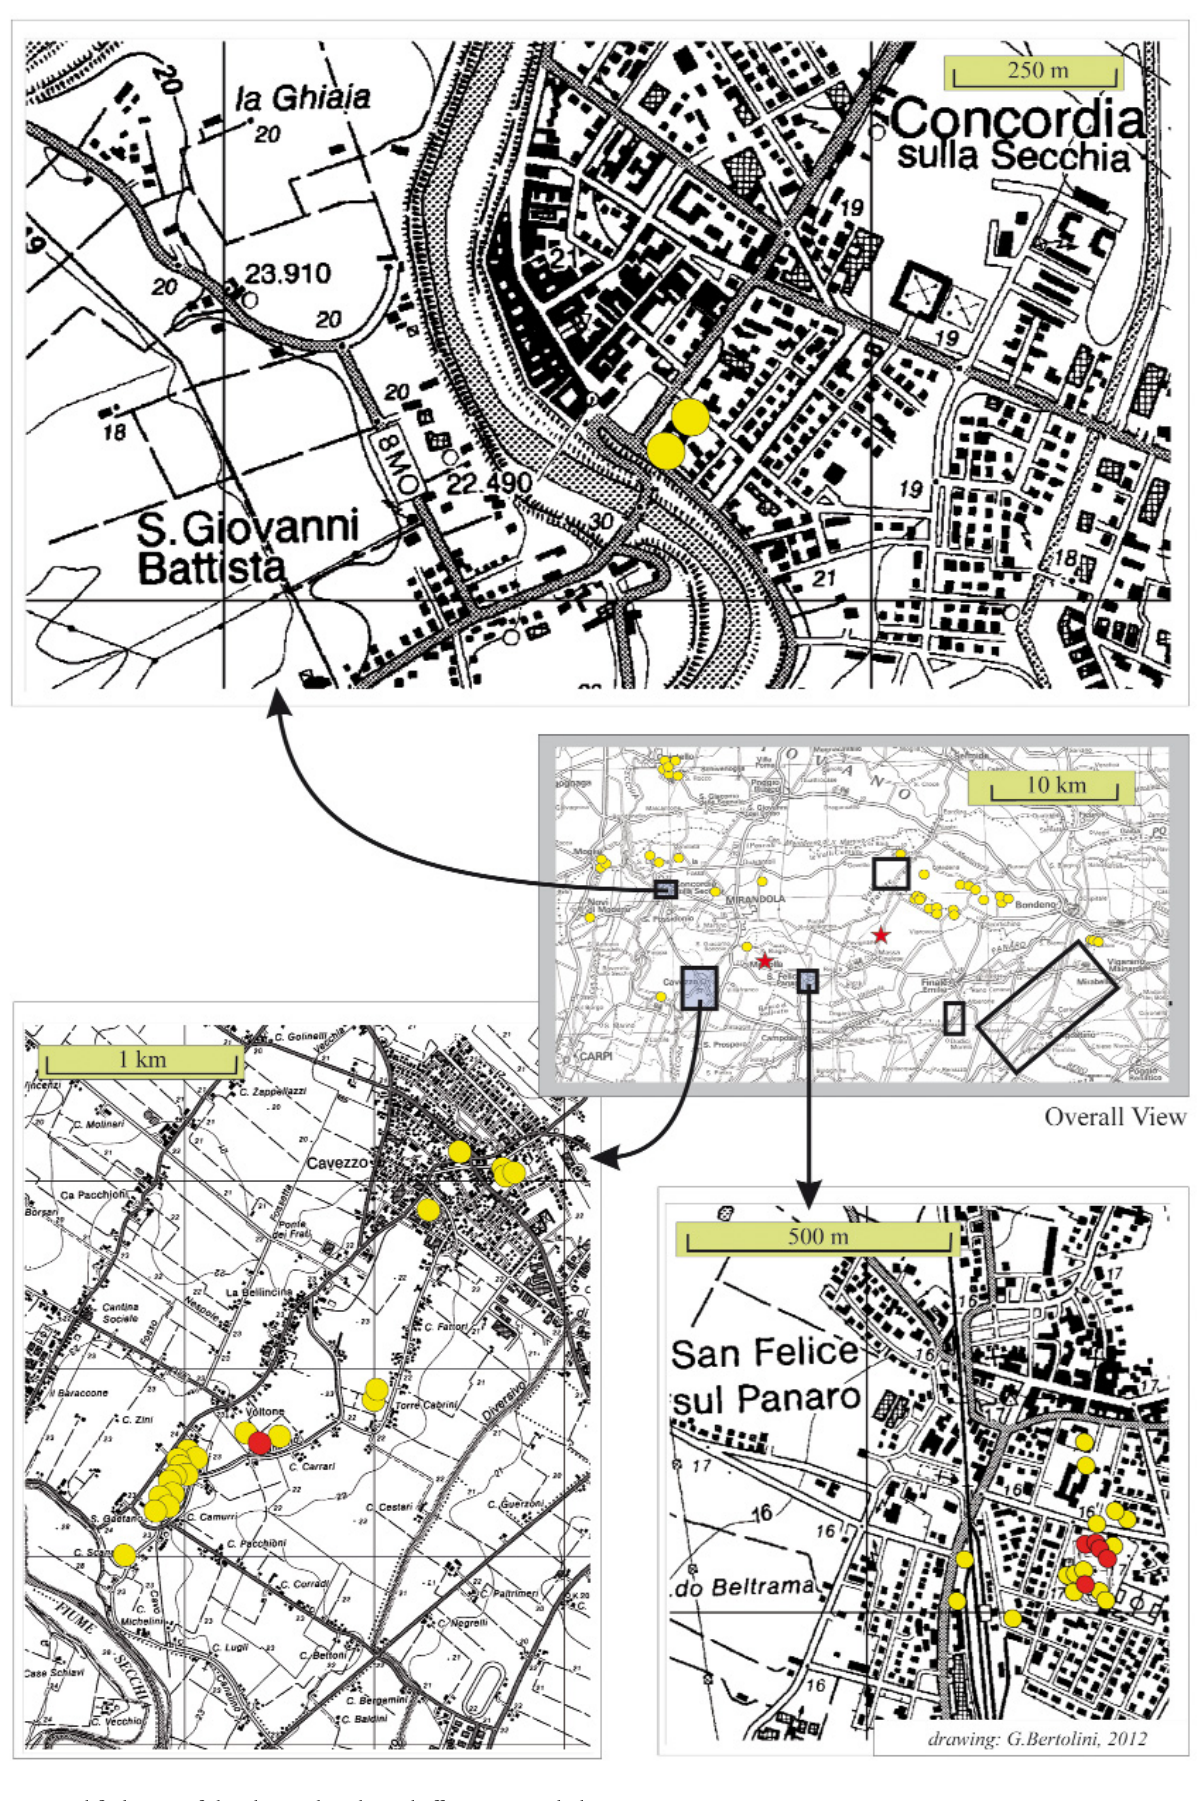
Figure 2a. Simplified maps of the observed geological effects. For symbols see